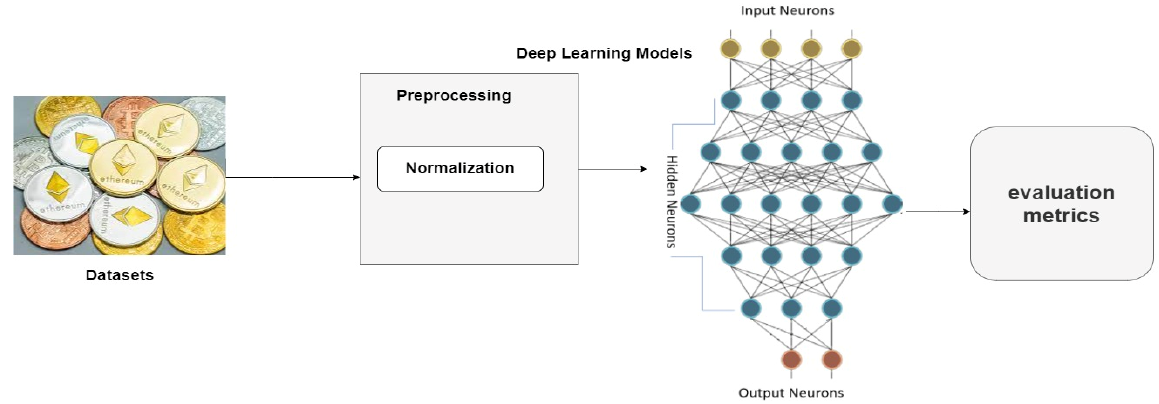
Figure 1. Framework of the system.